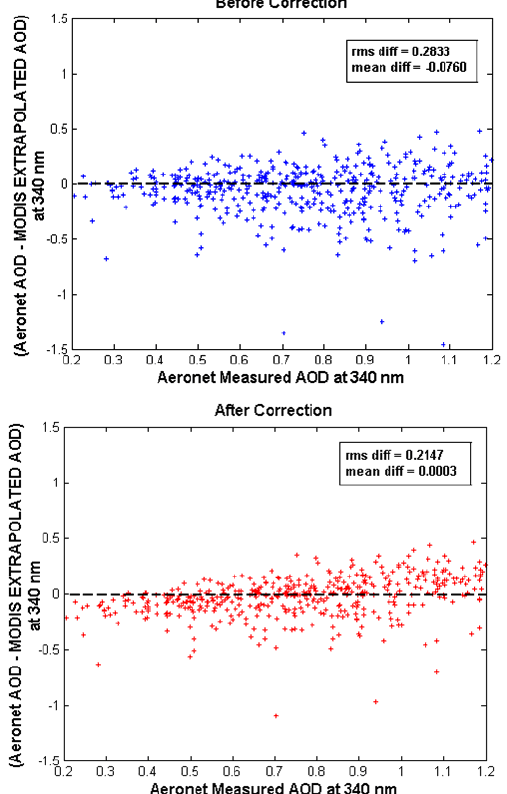
Fig. 3. The 1τ 340 versus AERONET-measured AOD at 340nm (a) before correction, and (b) after correction.